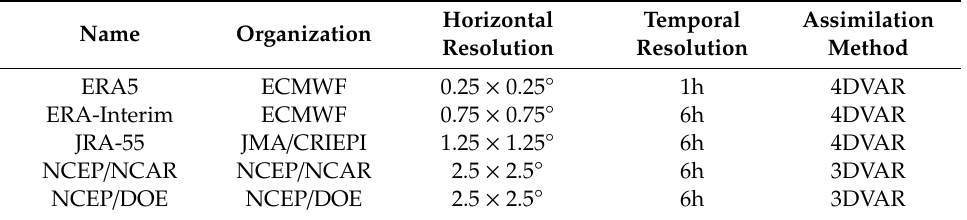
Table 1. Information on five global reanalysis